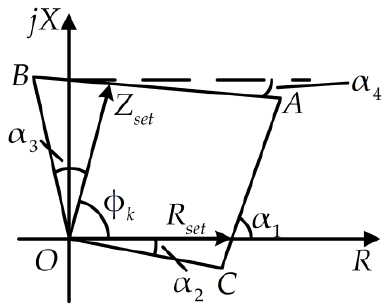
Figure 3. A common characteristic shape of quadrilateral relays.